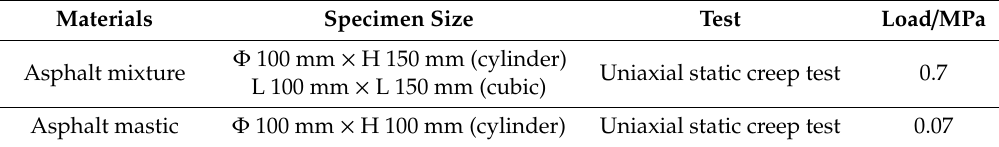
Figure 2. ( a ) The asphalt mastic specimens; ( b ) the uniaxial static creep test testing process. Table 2. Experimental program for the asphalt mixture and